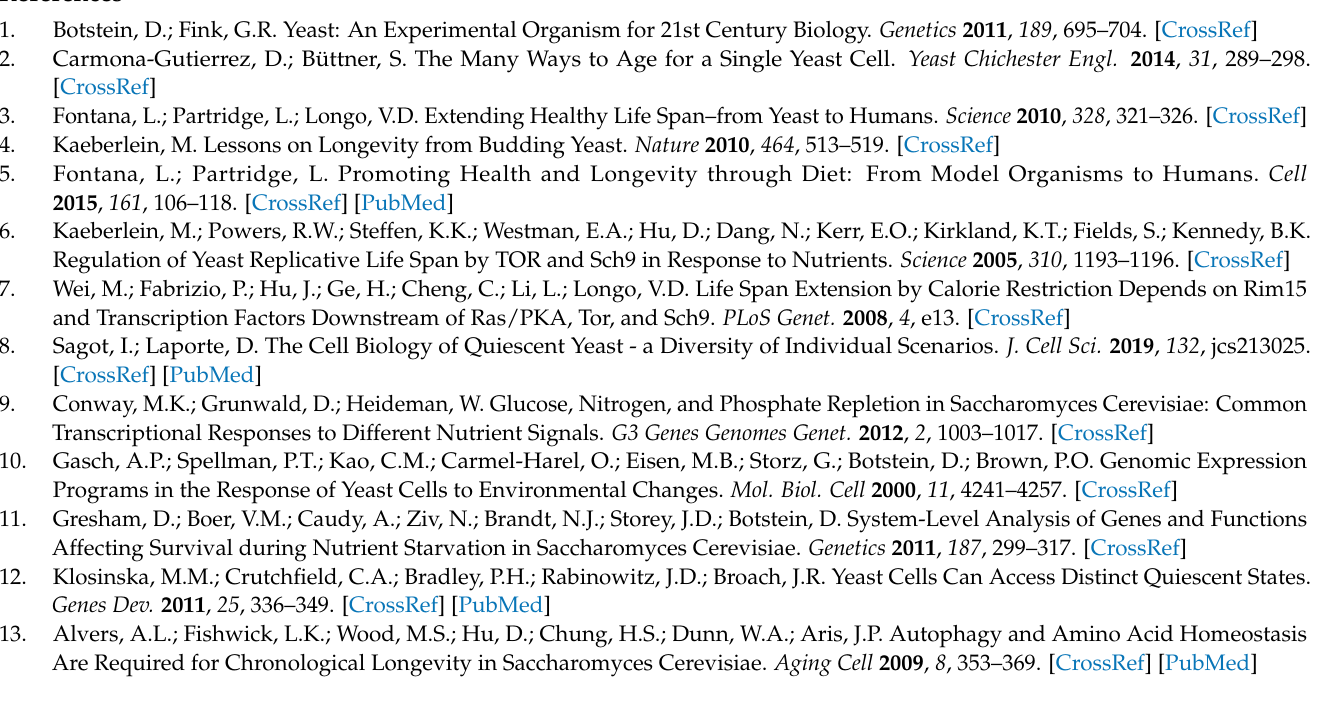
Figure S5: The MVB pathway and Pho85 are critical for survival upon nutrient limitation; Table S1: Yeast strains used in this study; Table S2: Oligonucleotides used for gene deletion, chromosomal tagging and